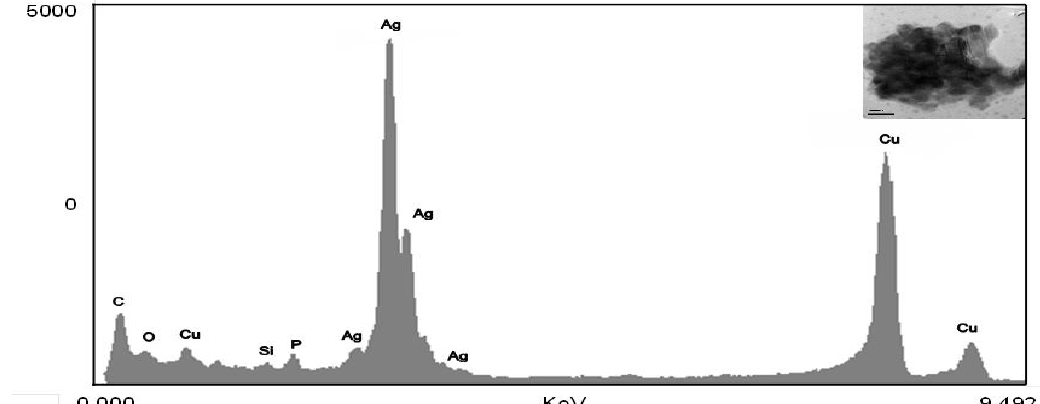
Fig. 4. EDS for AgNPs from leaves and